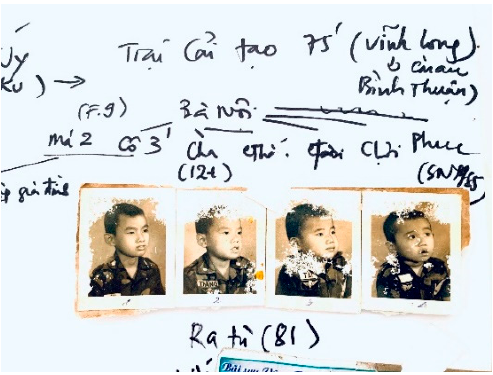
Figure 2. All my uncles, including my dad, were wearing military shirts when grandpa was still serving in the U.S. army.